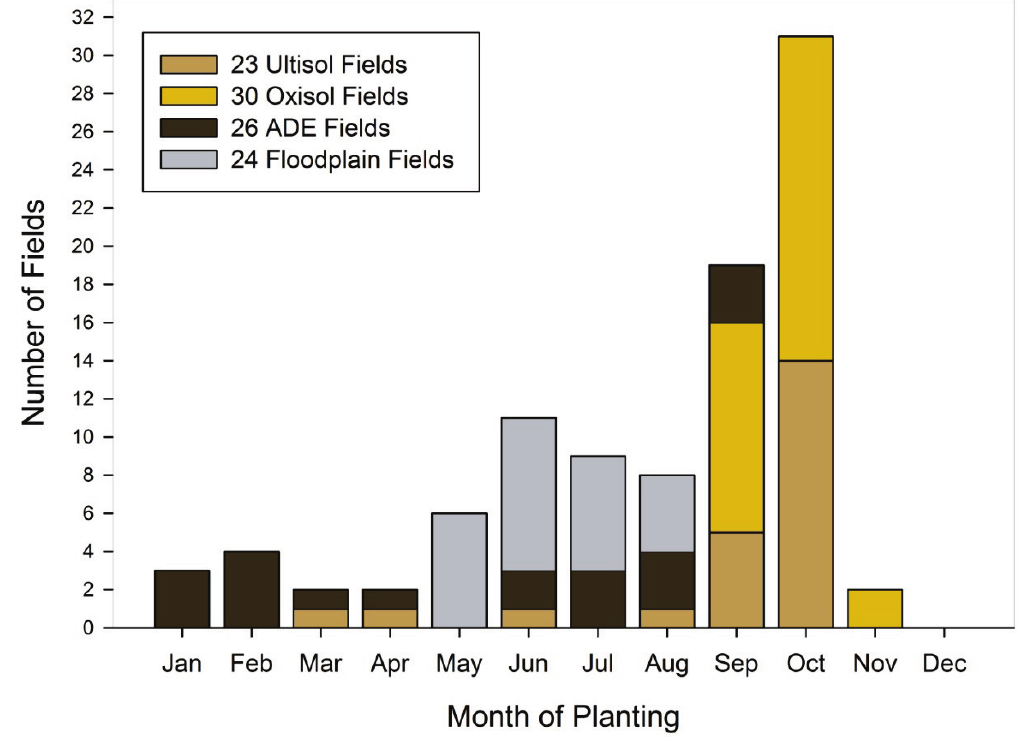
Figure 6. Month of planting for 103 bitter manioc fields in 4 types of soil on the middle Madeira River in the Municipality of Manicoré, Amazonas State,